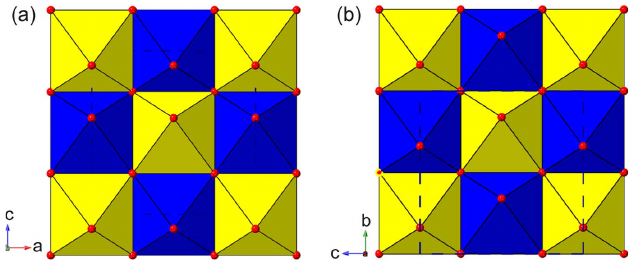
Figure 6 Comparison of the ( a ) X 3+ (0, a) and ( b ) X 4+ (0, a) modes, derived from the RP parent. Two layers are plotted, separated by half a unit cell. Notice that the top (yellow) layer tilt pattern is identical for each, but in the bottom (blue) layer tilts change in relative sense. The corresponding Glazer-like notation is a (cid:2) a (cid:2) c 0 / (cid:2) ( a (cid:2) a (cid:2) ) c 0 and a (cid:2) a (cid:2) c 0 / a (cid:2) a (cid:2) c 0 , respec- tively.